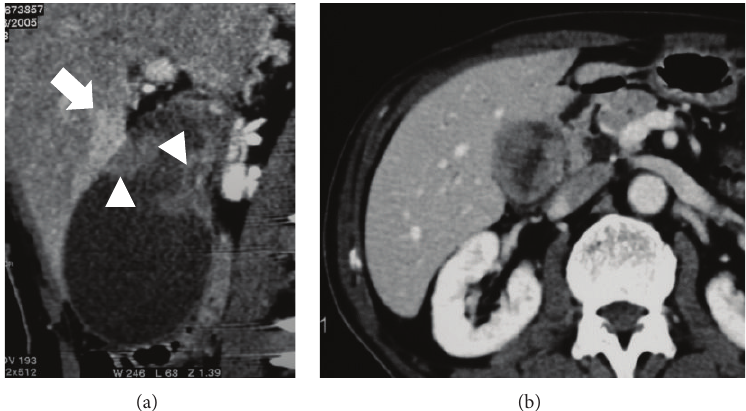
Figure 1: Longitudinal image of gallbladder cancer. Irregular mucosal enhancement with disruption of the enhanced mucosal line was visualized (arrowheads). Focal wall thickening and partial liver enhancement adjacent to the tumor were evident on longitudinal MPR imaging (arrow) (a). These phenomena were difficult to detect on horizontal images